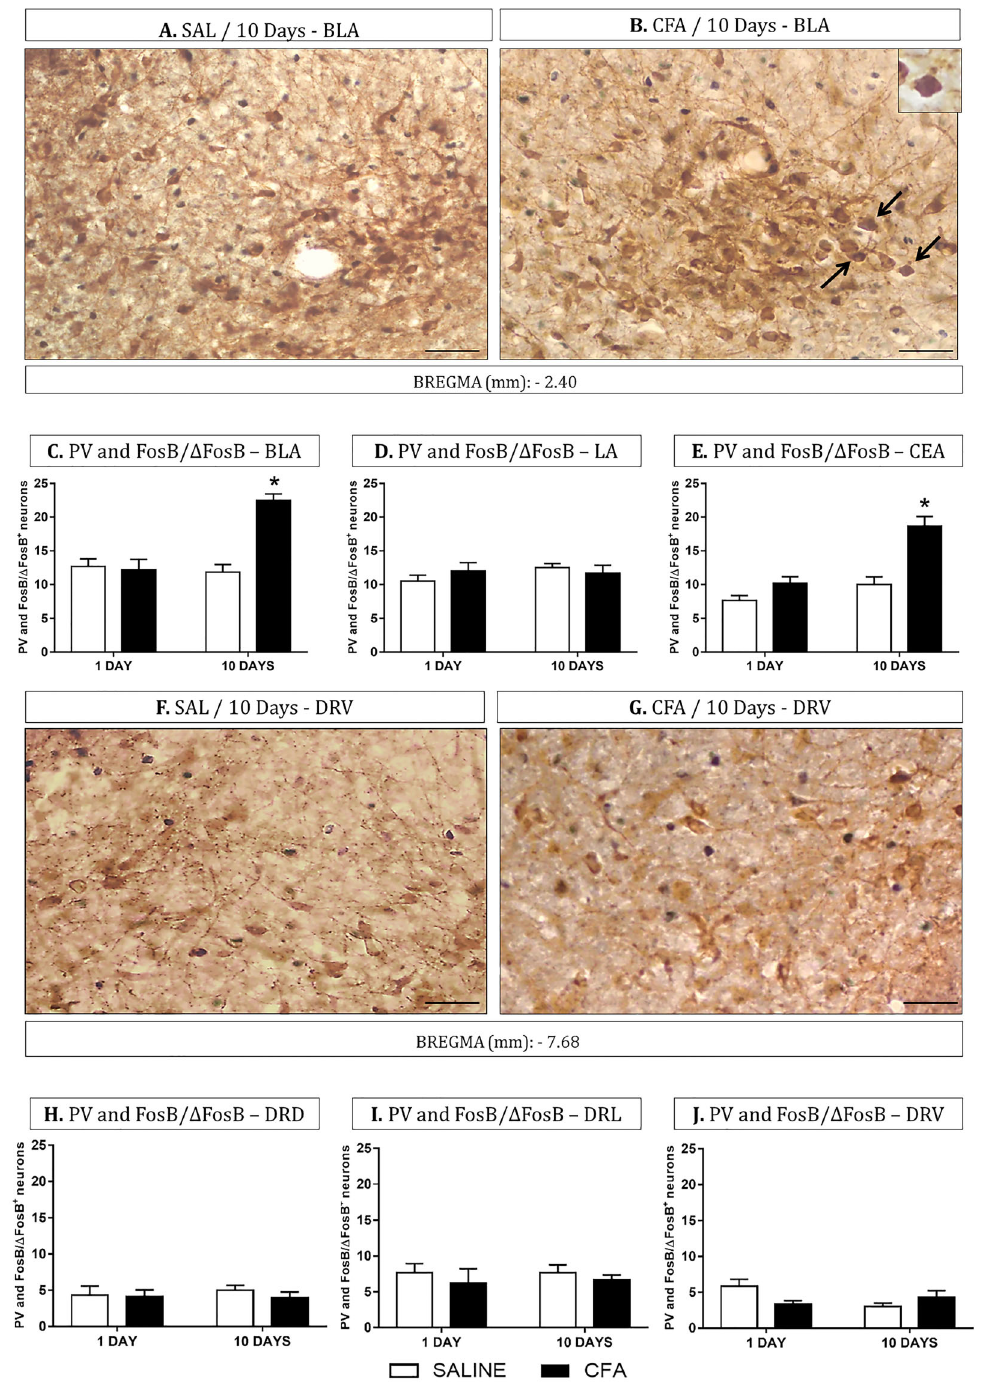
Figure 3. Representative photomicrographs of co-localization of FosB/ D FosB over the entire neuronal population of parvalbumin (PV), or unlabeled cells in the amygdala ( A – E ) and dorsal raphe ( F – J ) (n=6 per group). SAL: saline; CFA: complete Freund ’ s adjuvant. ( C – E ) Percent of co-localized PV and FosB/ D FosB + neurons in basolateral (BLA), lateral (LA), and central nuclei of the amygdala (CEA). ( H – J ) Percent of co-localized PVand FosB/ D FosB + neurons in the dorsal (DRD), lateral (DRL), and ventral (DRV) divisions of the dorsal raphe nucleus. Black arrows indicate FosB/ D FosB + (gray nucleus), PV + (brown cell body), and unlabeled (cell body not labeled) neurons. Data are reported as means ± SE. *P o 0.05 vs Day 1/CFA group and Day 10/control group (saline) (Newman-Keuls test). Magni fi cation, 40 (cid:3) ; scale bars, 100 m